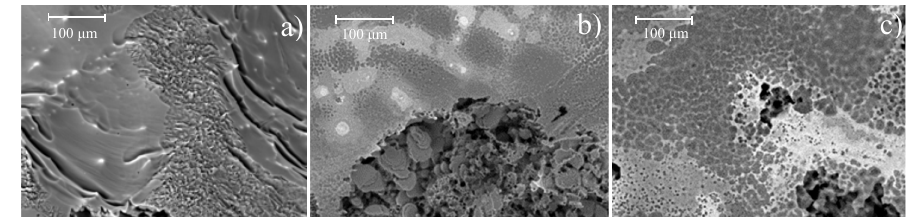
Figure 10. SEM images of the topography of ( a ) pure magnesium and ( b ) Mg-0.375Ga and ( c ) Mg-1.5Ga as-cast alloys after 168 h of immersion in SBF.